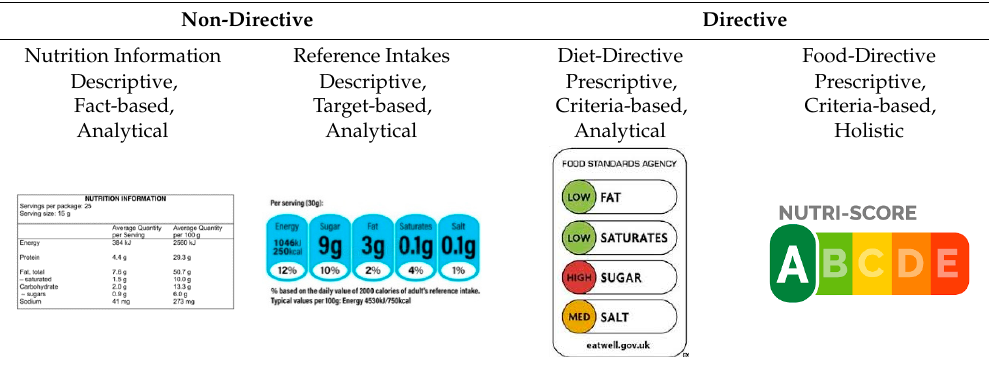
Table 1. Description and examples of front-of-packs labelling systems (FoPLs) according to their Directiveness. Descriptive, Descriptive, Prescriptive,